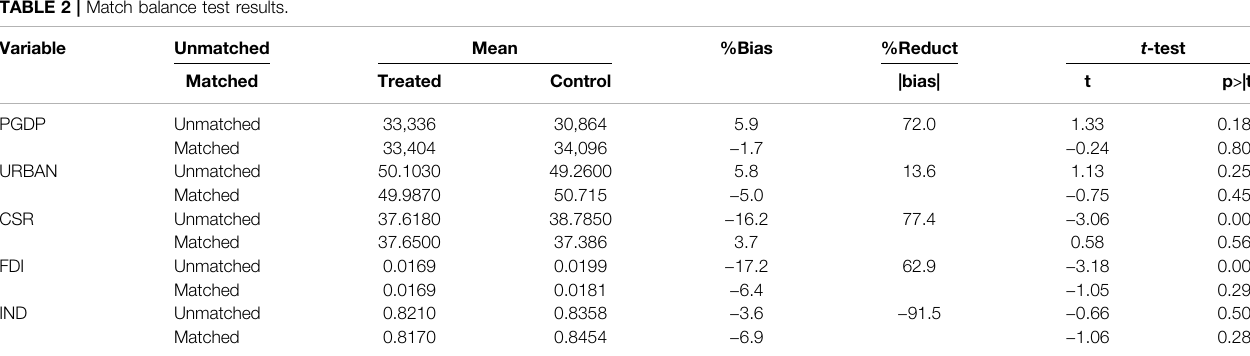
TABLE 2 | Match balance test